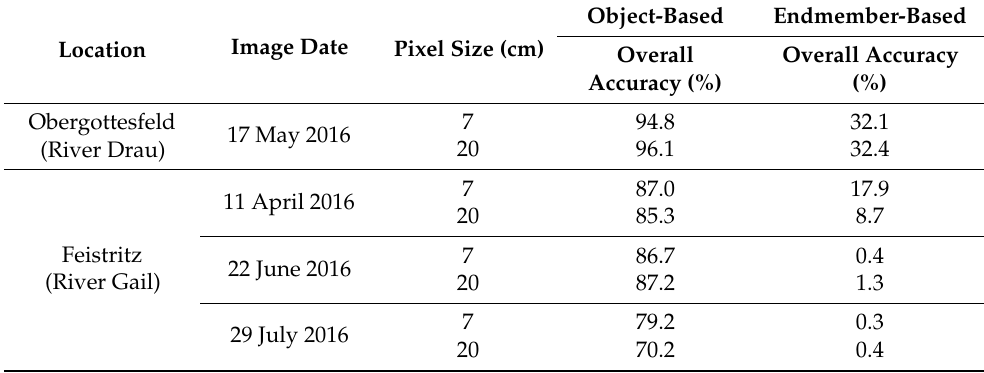
Table 7. Overall accuracies for the classifications of the narrow-band